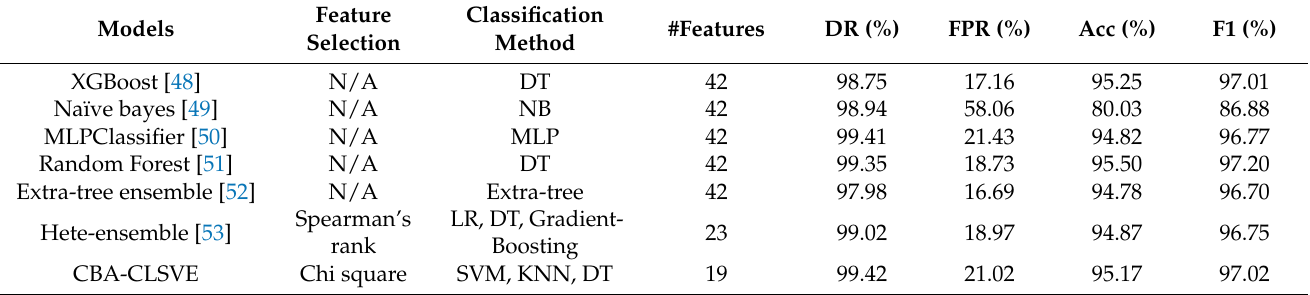
Table 12. Comparison results with other approaches for intrusion detection on the UNSW-NB15